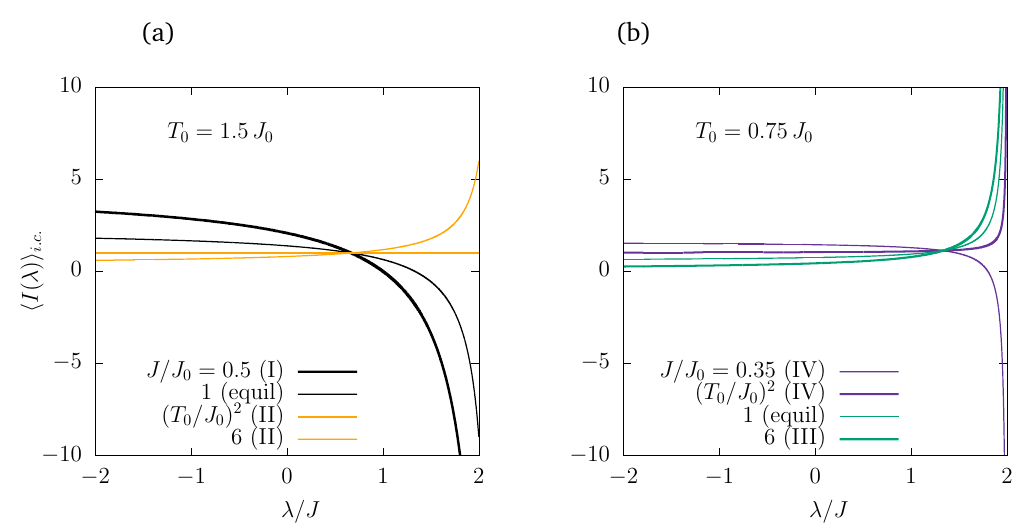
Figure 3: The spectrum of constants of motion averaged over the initial condi- tions. Extended (a) and condensed (b) initial conditions are plotted separately in the two panels for parameters given in the two